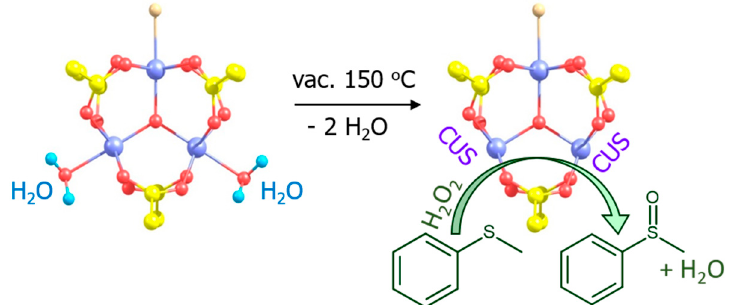
Figure 2. Activation of MIL-101 and thioether oxidation over coordinatively unsaturated sites (CUS).